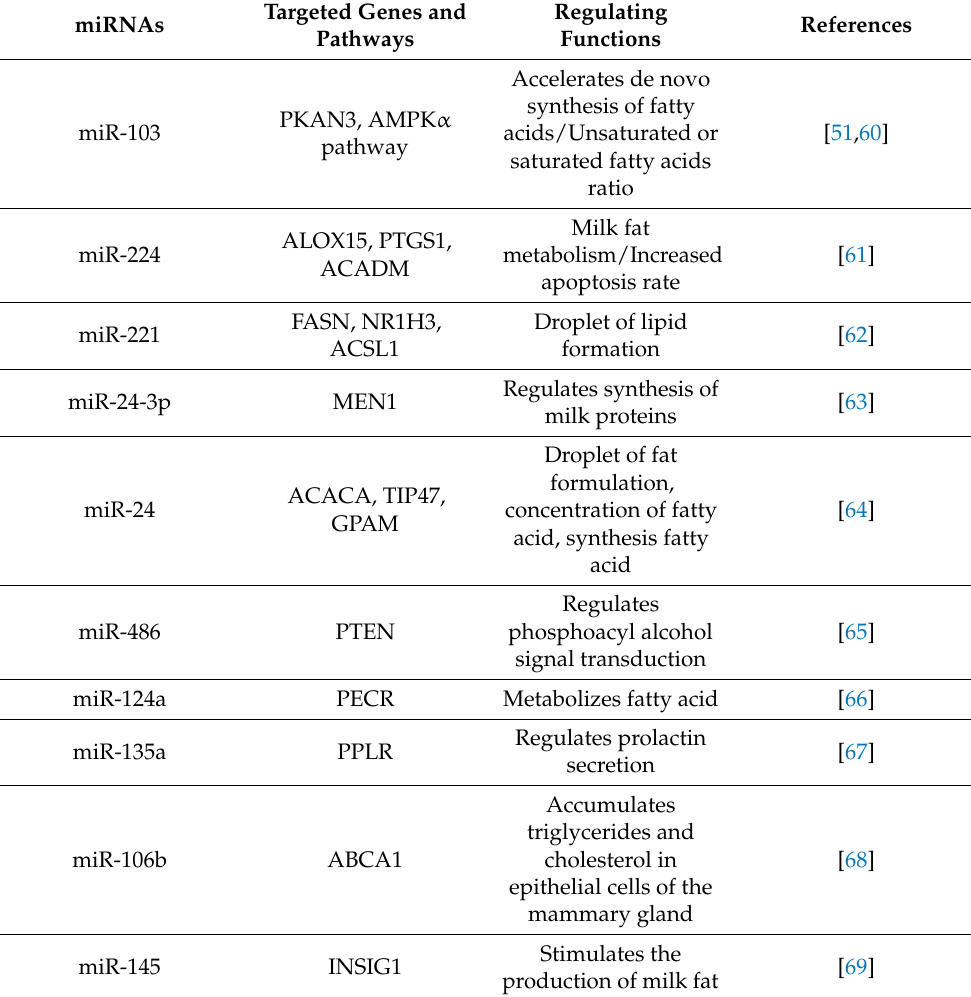
Table 1. MiRNAs involved in the regulation processes of mammary lipid metabolism of